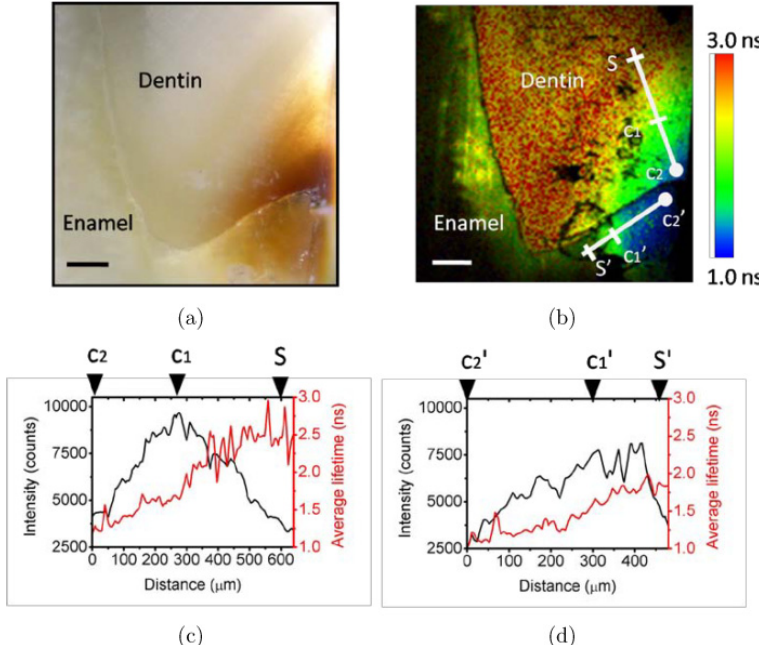
Fig. 11. (a) Dental caries image, (b). Dental caries FLIM image, scale bar ¼ 200 (cid:1) m, the decrease in lifetime in the caries area, black represents enamel, red represents dentine. The average lifetime section line: (c) dentine and (d) enamel. 46 (Permission has been granted by \Biomedical Optics